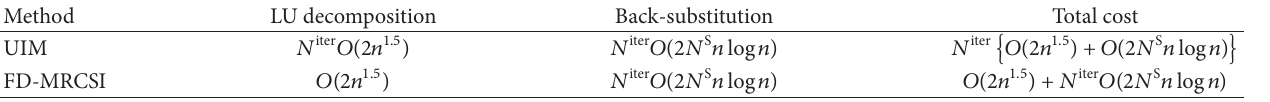
Table 1: Computational complexity for FD-MRCSI and